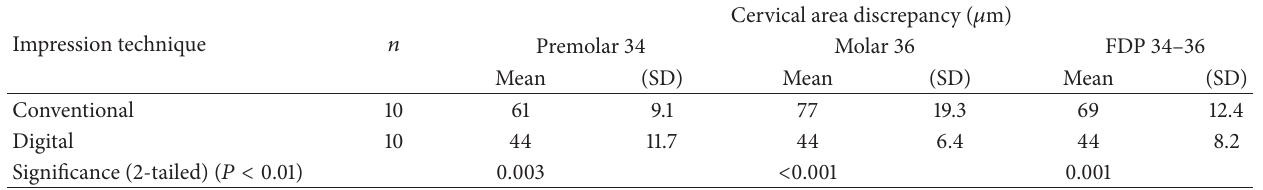
Table 3: Cervical area discrepancy for conventional and digital impression